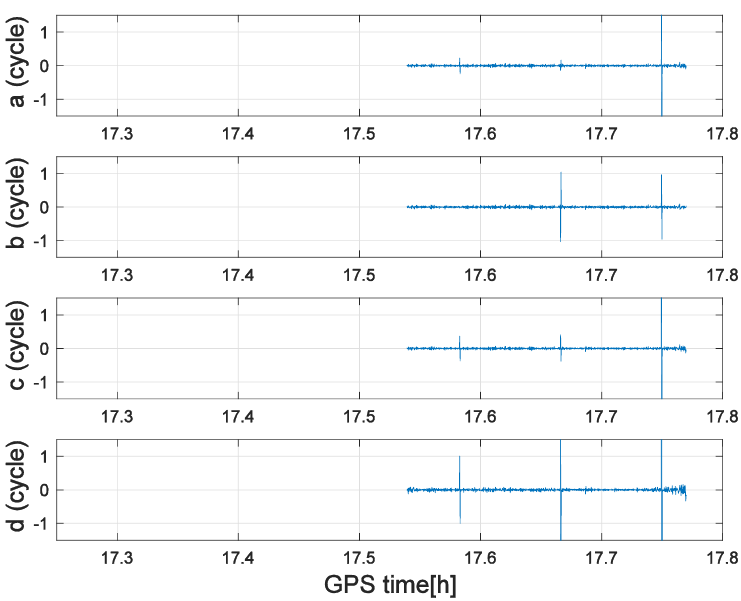
Figure 8. Cycle slip detection results for GPS PRN 22 using STG combinations in Equations (10) – (13), denoted by ( a – d ), respectively, with simulated cycle slip pairs at GOCE on 21 November 2009.